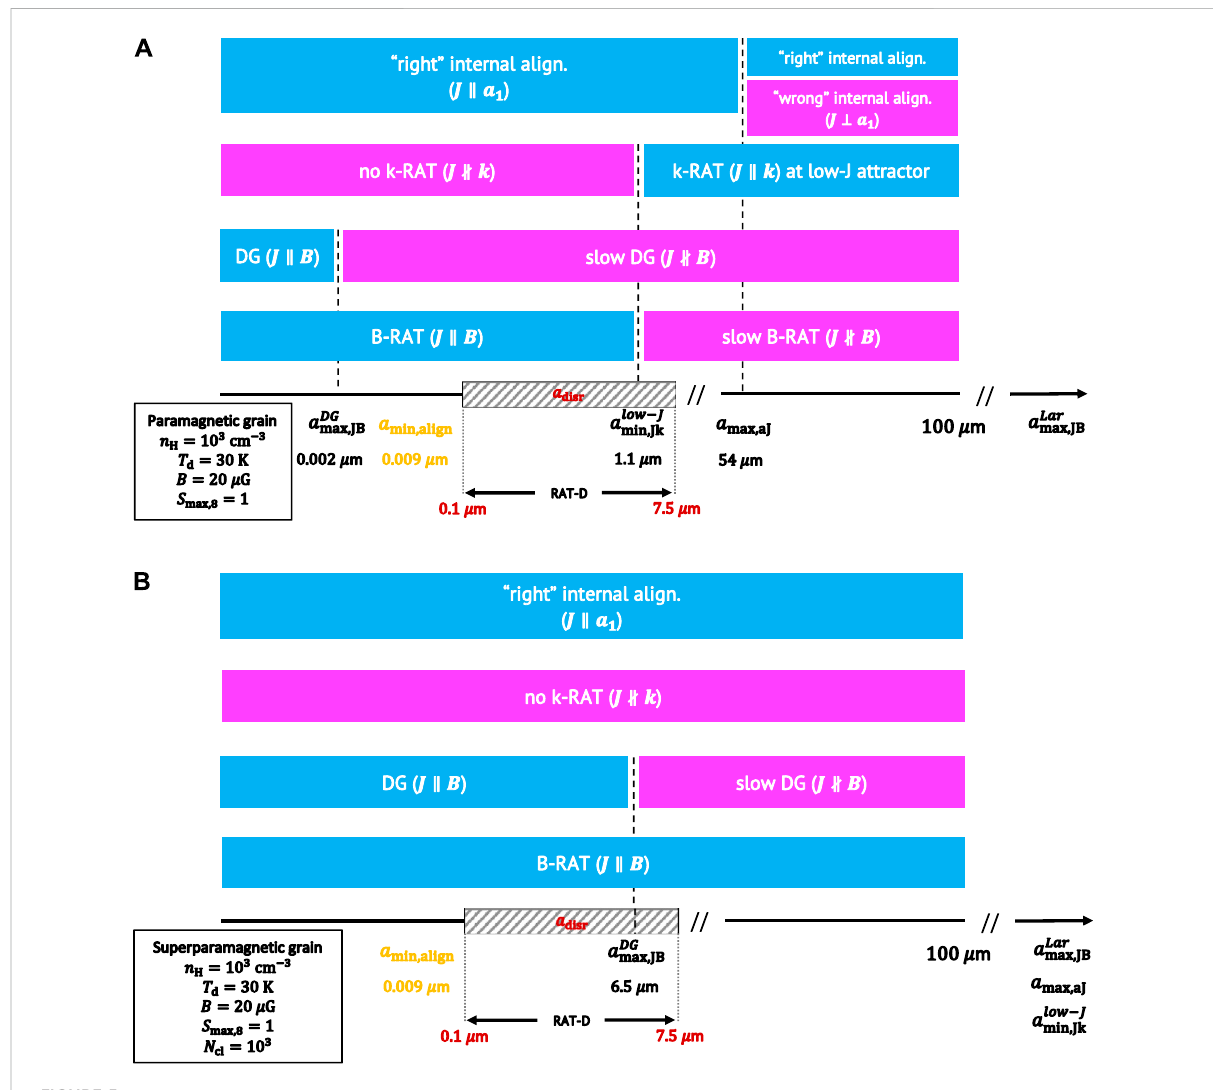
FIGURE 5 (A) Alignment of paramagnetic grains for a typical molecular cloud in proximity to an ionization source with γ = 1 and (cid:2) λ (cid:3) 0 . 5 μ m. The internal alignment of most grains is ef fi cient (i.e., a 1 (cid:1) J ). For the external alignment, the paramagnetic relaxation (DG mechanism) is much less ef fi cient than Larmorprecession(B-RAT)toalign J with B .Grainswithmicro-sizearealignedwithmagnetic fi elds.Largergrainsareexpectedtoalignwithradiation fi eld (k-RAT). (B) Similar but for superparamagnetic grains with N cl = 10 3 . Due to the enhancement of the grain susceptibility (1) all grains are internally aligned with J perpendicular to a 1 , (2) DG mechanism is effective to larger grain size, and (3) all grains are externally aligned with magnetic fi elds. Note that the B-RAT is much more effective than DG